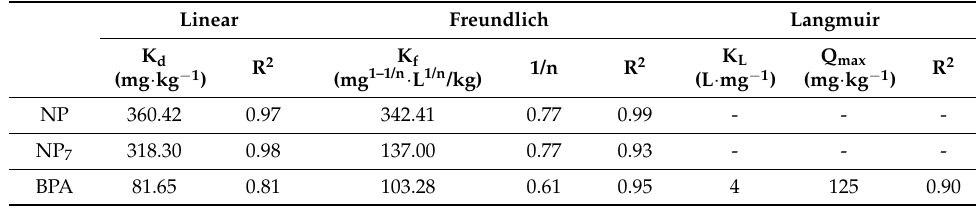
Figure 1. Adsorption of ( a ) NP, ( b ) NP 7 and ( c ) BPA on soil. Note: C e indicates the concentrations of pollutants in the liquid (mg · L − 1 ). C s indicates the concentrations of pollutants adsorbed on the soil (mg · L − 1 ). Table 2. Adsorption models for NP, NP 7 and BPA on